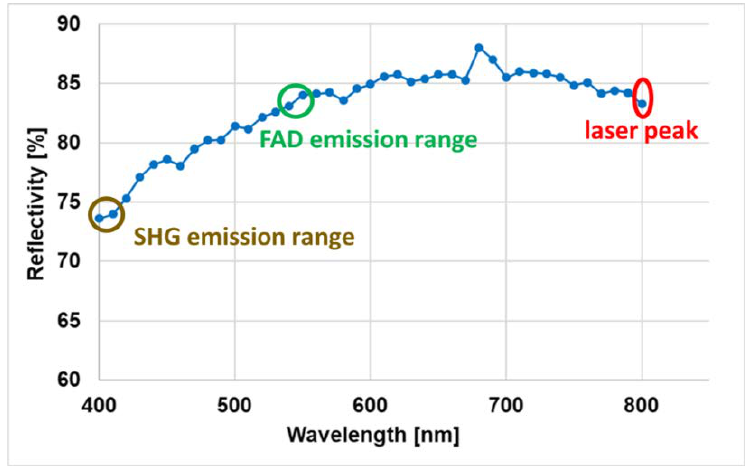
Figure 4. Measured reflectivity of the MEMS mirror plate.